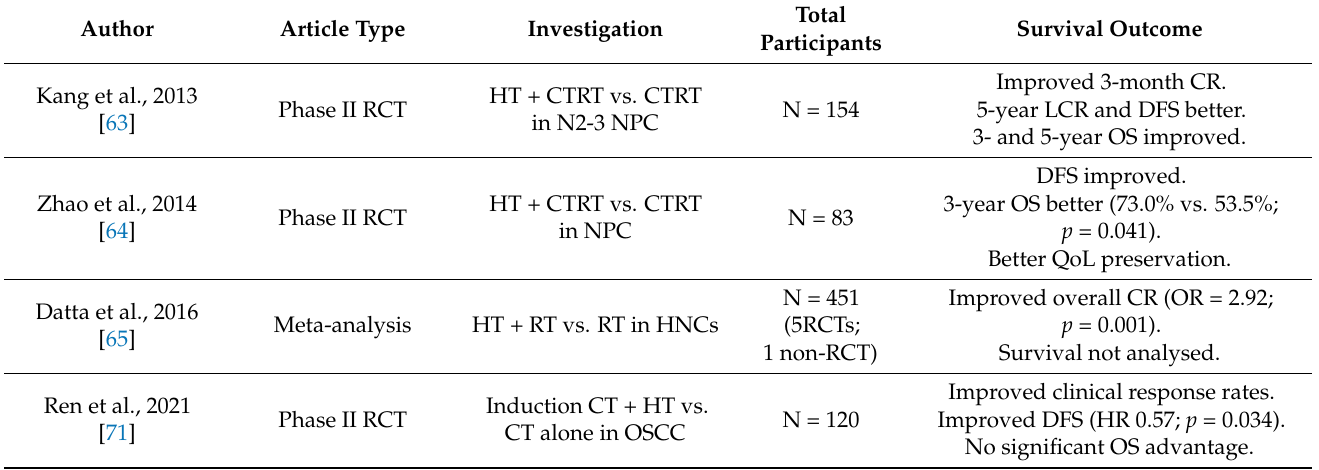
Table 4. HT in patients with head and neck cancers, including NPC. Summary of articles